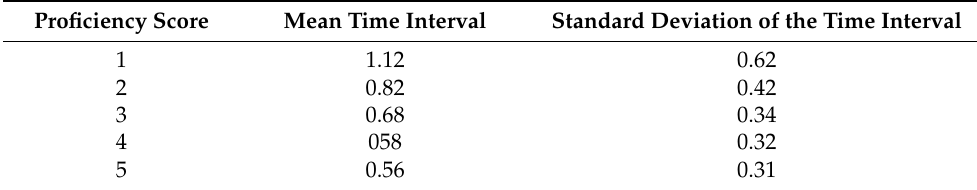
Table 2. Example of the mean rhythm scores. Proficiency